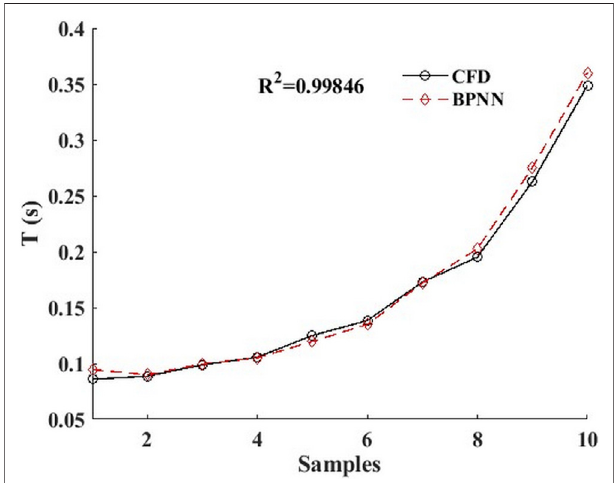
FIGURE 6 | BPNN prediction value and CFD real value of 10 groups of calculation examples based on time-dependent leukocyte transmigration prediction mode.